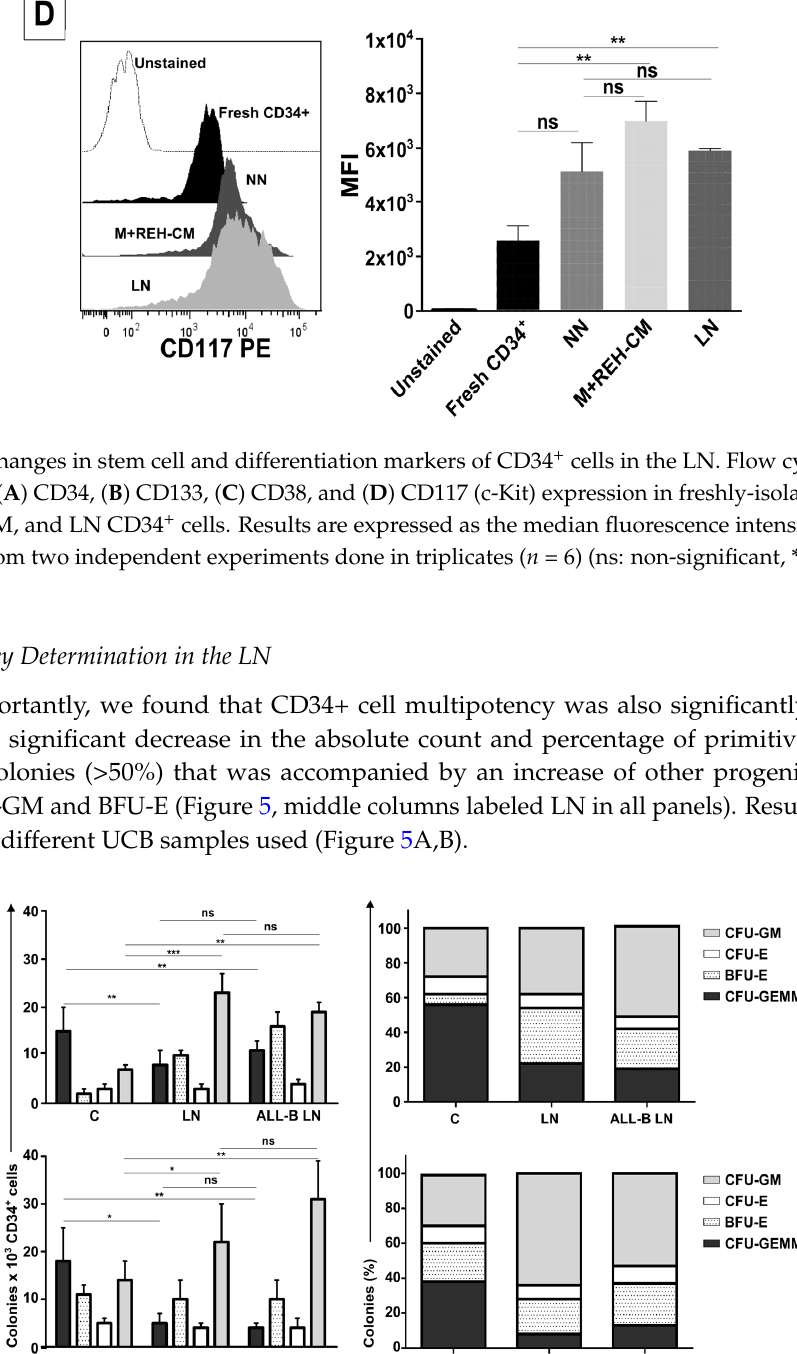
Figure 5. Reduced primitive colony forming units of CD34+ cells exposed to the LN. Colony-forming units of granulocyte/erythrocyte/monocyte/megakaryocyte (CFU-GEMM), burst forming unit erythroids (BFU-E), CFU-erythroids (CFU-E), and CFU-granulocyte/macrophage (CFU-GM) by CD34+ co-cultured in the NN or the LN (LN established with REH cells, middle columns; LN established with primary ALL-B cells, right columns); absolute (left panels) and relative counts (right panels) for two different CD34+ samples were performed in duplicate ( n = 4), panels ( A ) and ( B ), are shown. Results are expressed as the mean ± SEM ( p -values: non-parametric one-way ANOVA; ns: non-significant, * p < 0.05, ** p < 0.01, *** p < 0.001).